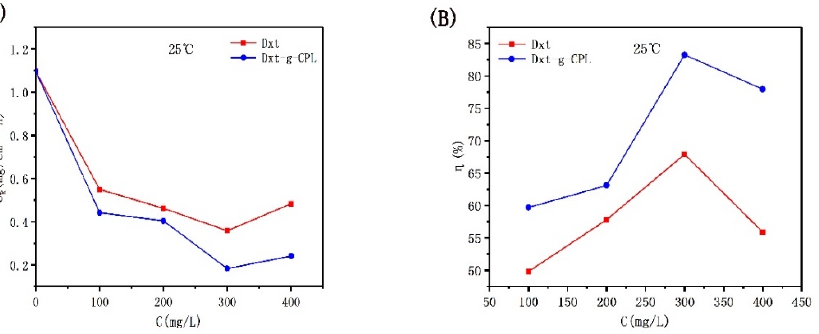
Figure 4. CR and η of J55 steel added with different concentrations of corrosion inhibitor in 1 M HCl solution. ( A ) Dxt; ( B ) Dxt-g-CPL.